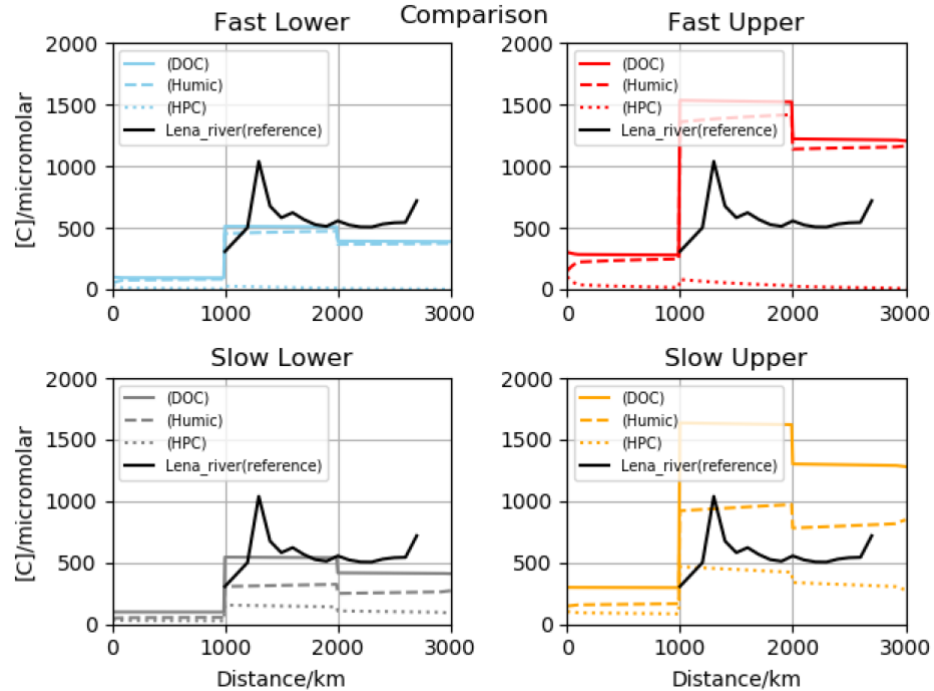
Figure 2. Transformations for reprocessed forms and also the total of dissolved carbon, together highlighting mixing factors and selected chemical rates along the 3000 km network. Real Lena DOC measurements are superimposed from the 1000 km threshold for comparison.